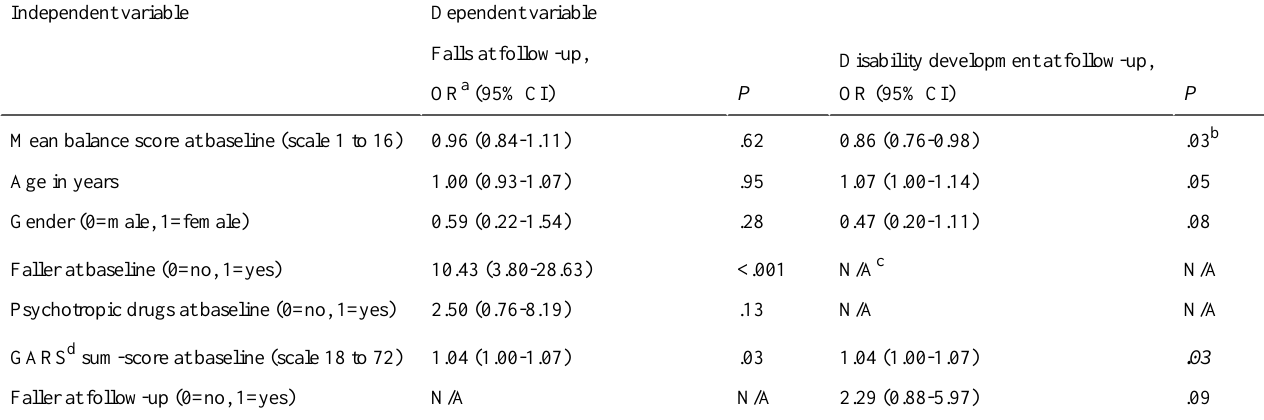
Table 2. Univariate association between baseline variables and falls and disability development after 6 months of follow-up (n=128).